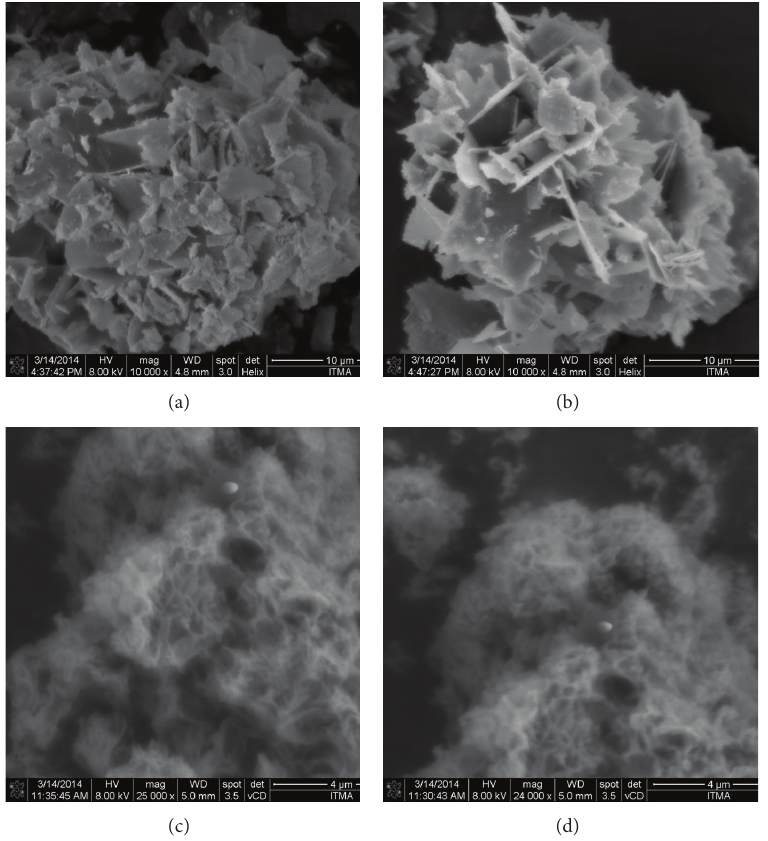
Figure 5: FESEM micrographs of ZLH ((a) and (b)) and PAS-ZLH (nanocomposite-A) ((c) and